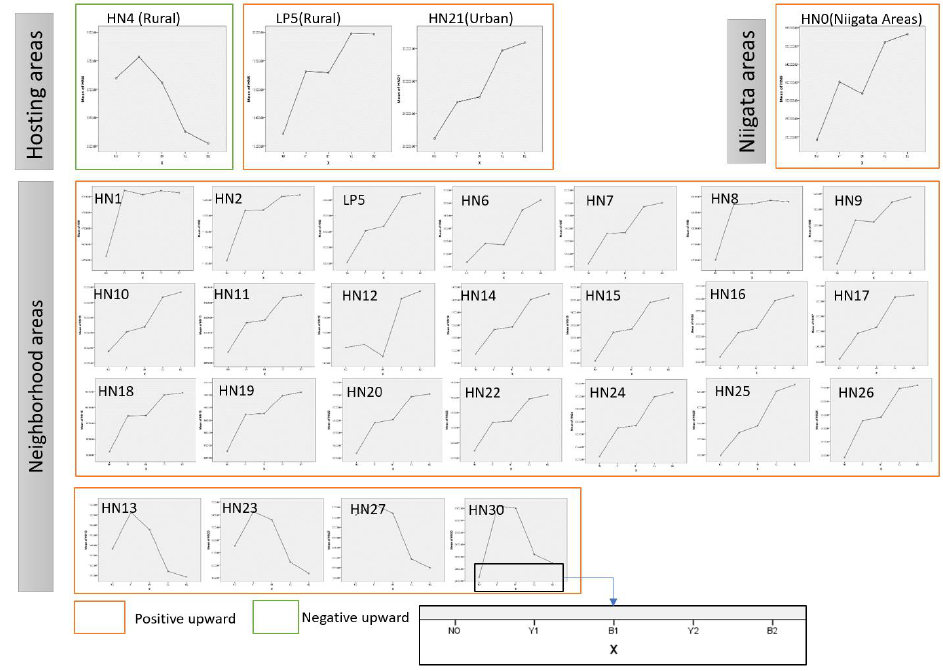
Figure 12. Mean plots (HN, HNGR): other areas in Niigata.